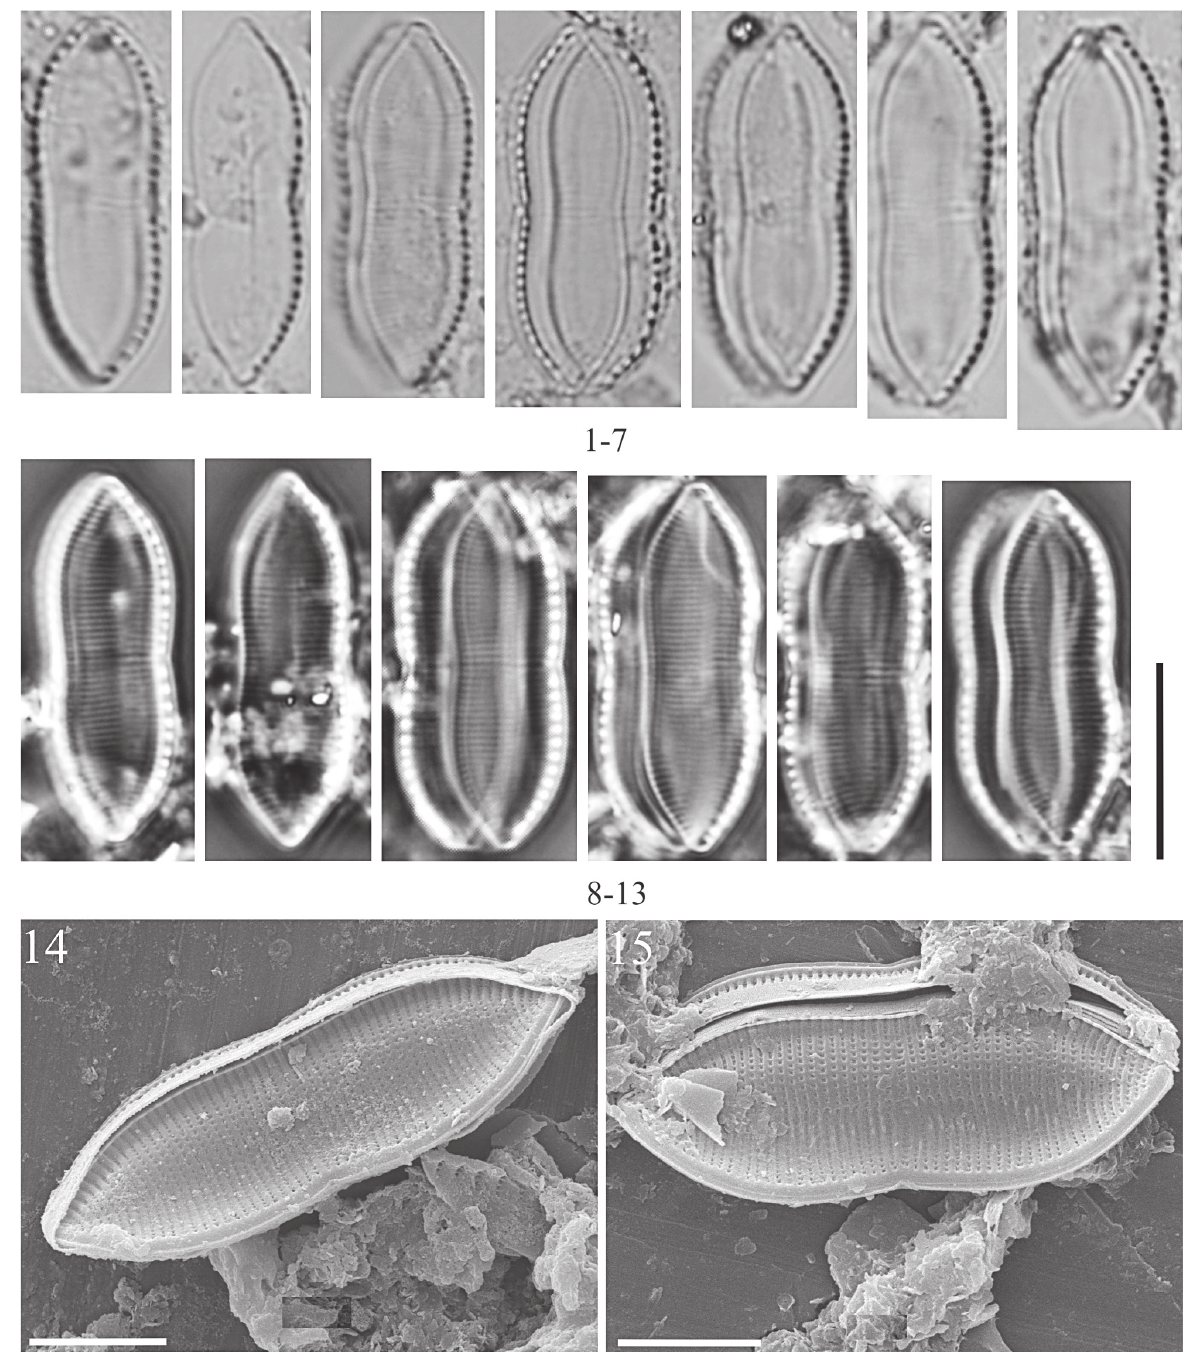
Figs 1-15 - Tryblionella persuadens comb. nov. 1-7 . Valves in bright field (LM). 8-13 . Valves in phase-contrast (LM). 14-15 . Whole frustules in SEM. Scale Bars: Figs 1-13 = 10 µm, 14-15 = 5